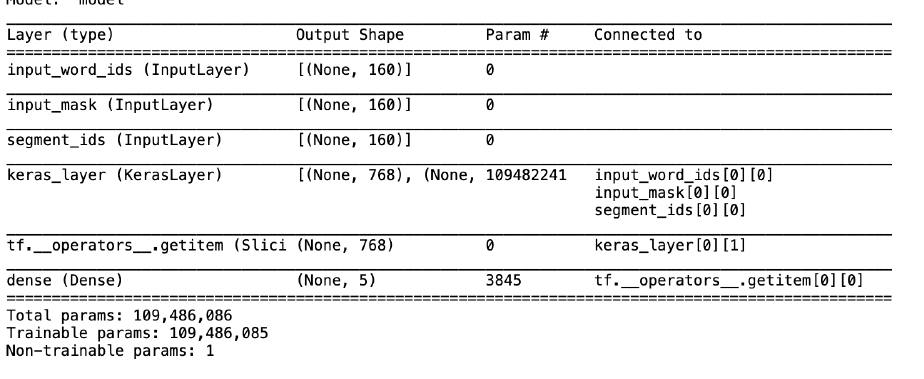
Figure 5. Architecture of our BERT model